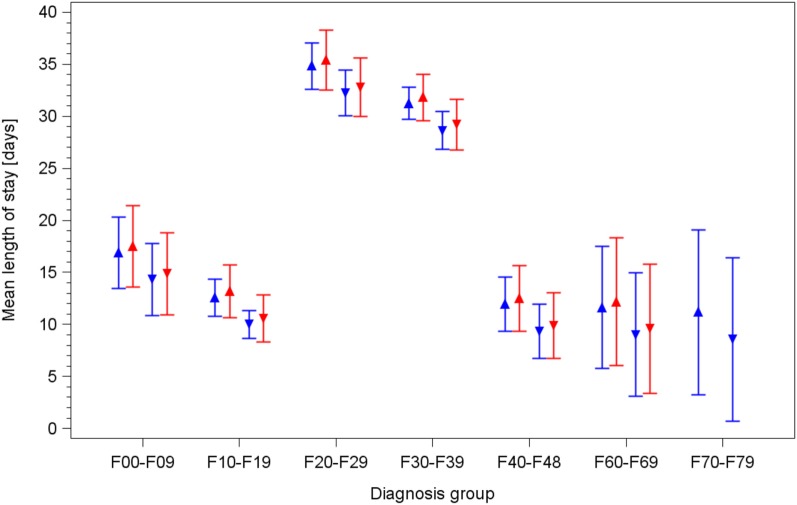
Mean duration of stay for inpatients in both standard care and integrated care/model project groups, by diagnosis and sex, estimated by the final model of backward analysis of variance. Upward triangles: females; downward triangles: males. Blue lines/symbols: standard care; red lines/symbols: integrated care/model project.